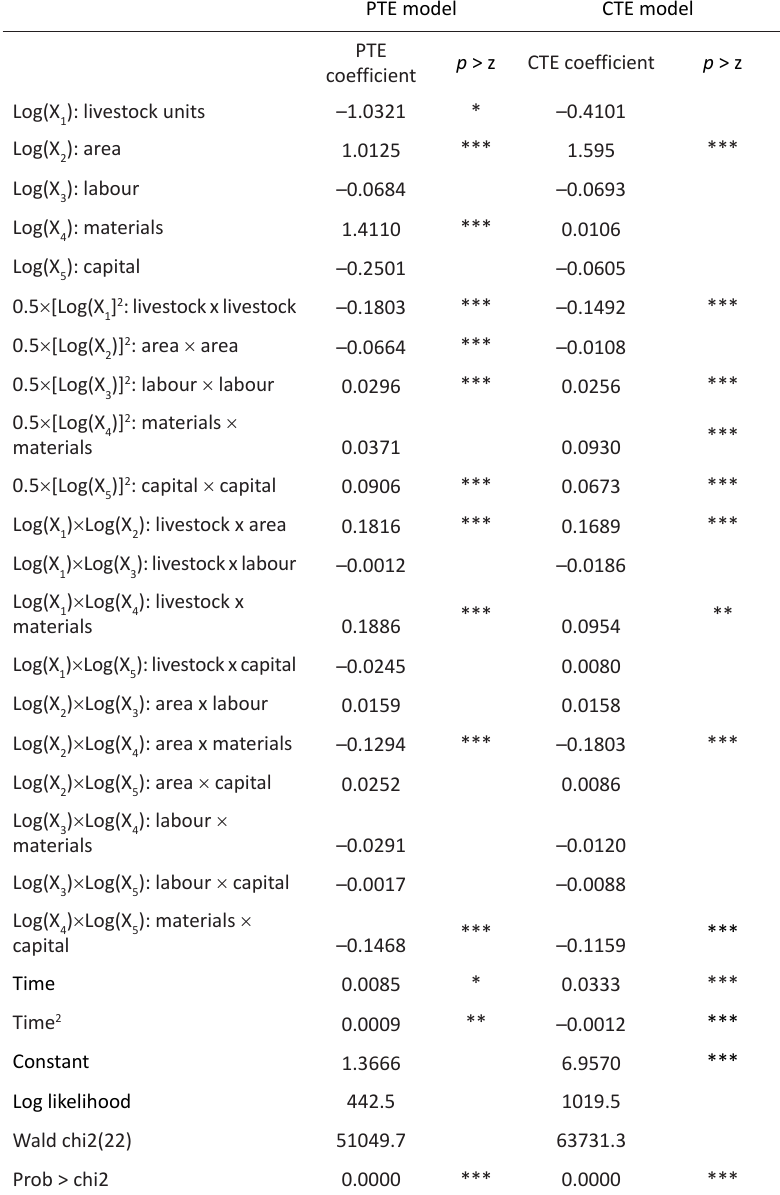
Table A1. Stochastic frontier production function parameters estimated for the pure technical efficiency (PTE) model and the compensated technical efficiency (CTE) model PTE model CTE model PTE